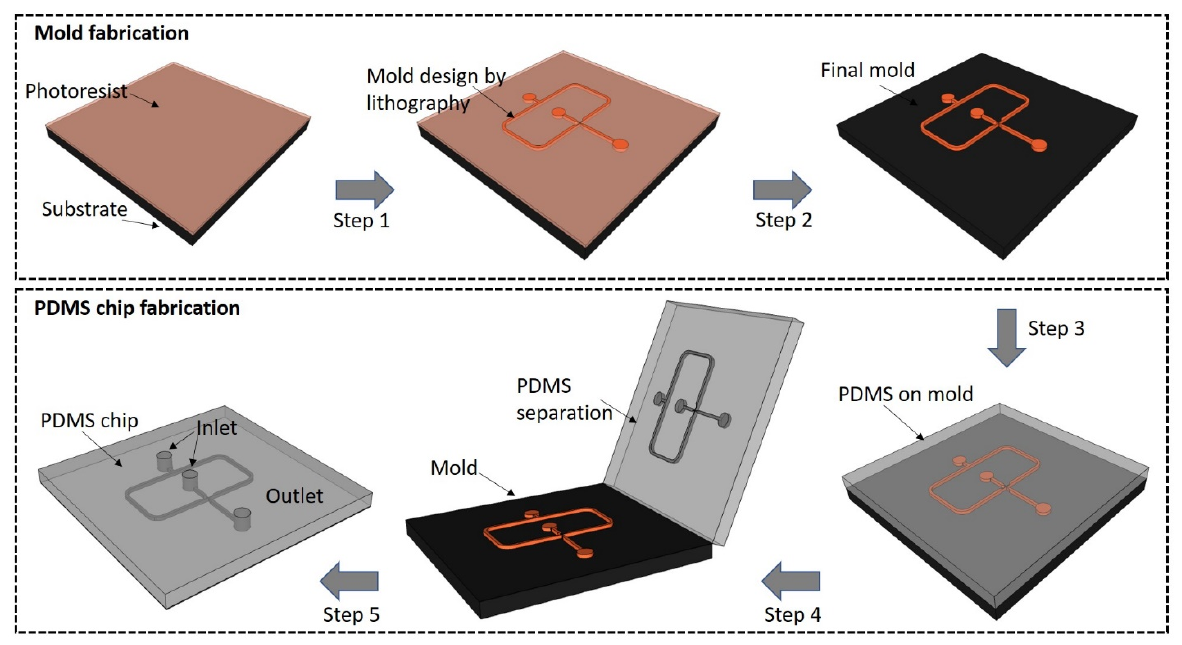
Figure 1. Schematic representation of a droplet generator microchip based on the technology used in our laboratory: ultrashort pulsed laser lithography applied for the mold fabrication (steps 1 and 2) followed by PDMS casting (steps